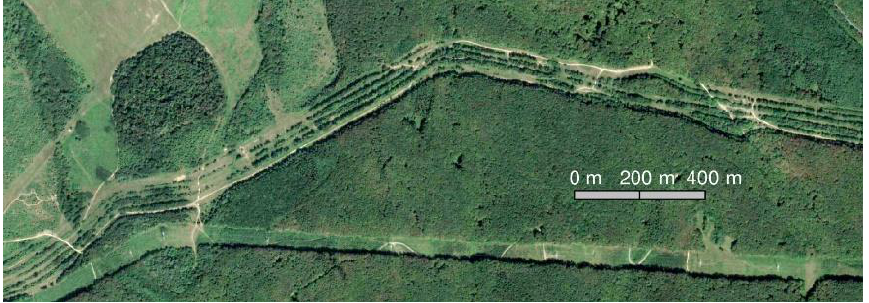
Figure 2. Part of parallel underground lines of the Eustream transport network recognizable on a satellite image.